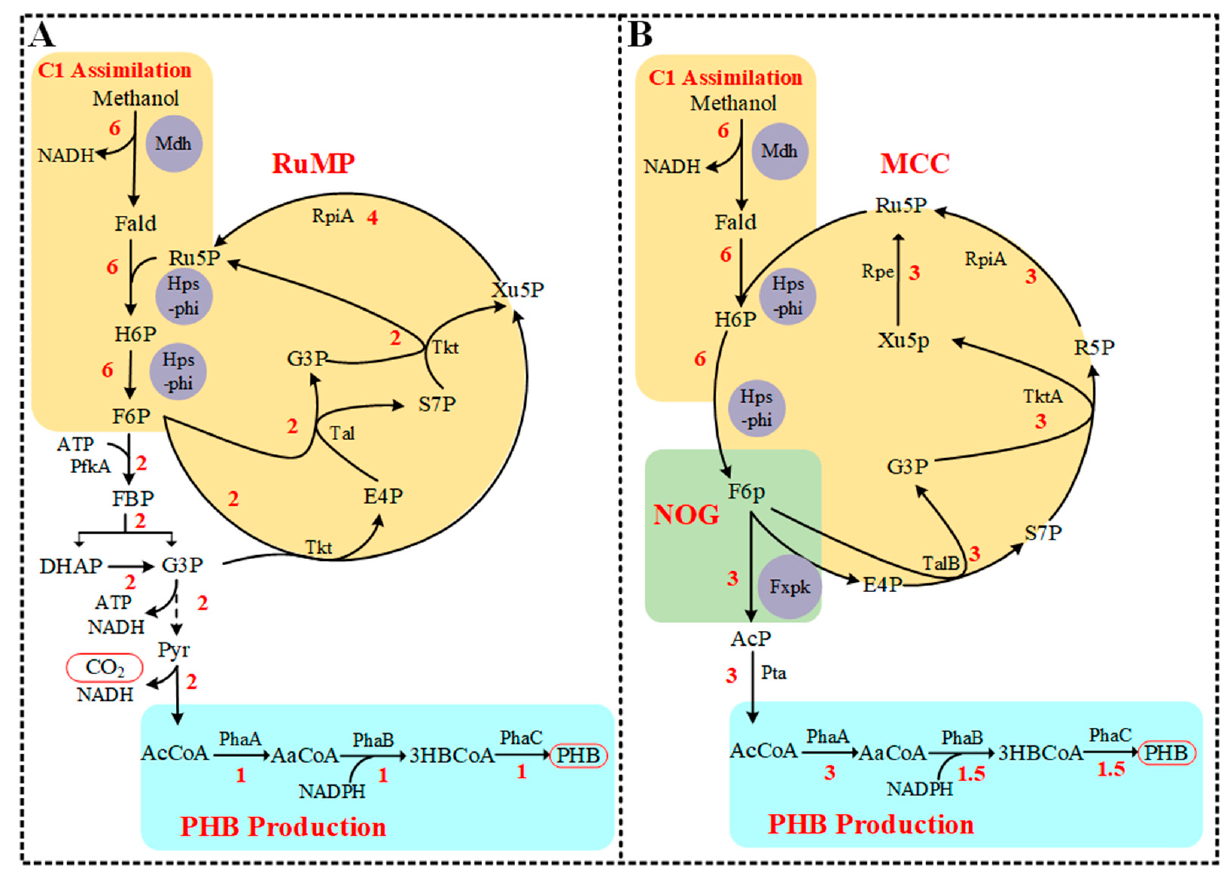
Figure 1. Conversion of methanol to PHB by RuMP pathway ( A ) and MCC pathway ( B ) calculated using flux balance analysis of an extended E. coli metabolic network. The C1 assimilation module